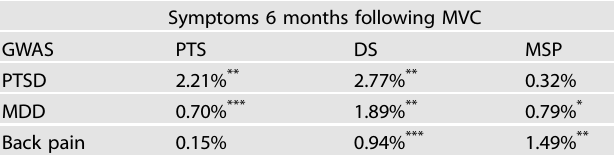
Table 2. Variance (Nagelkerke ’ s pseudo- R 2 ) explained by PRS in predicting PTS, DS, and MSP 6 months following MVC trauma in a cohort of European American